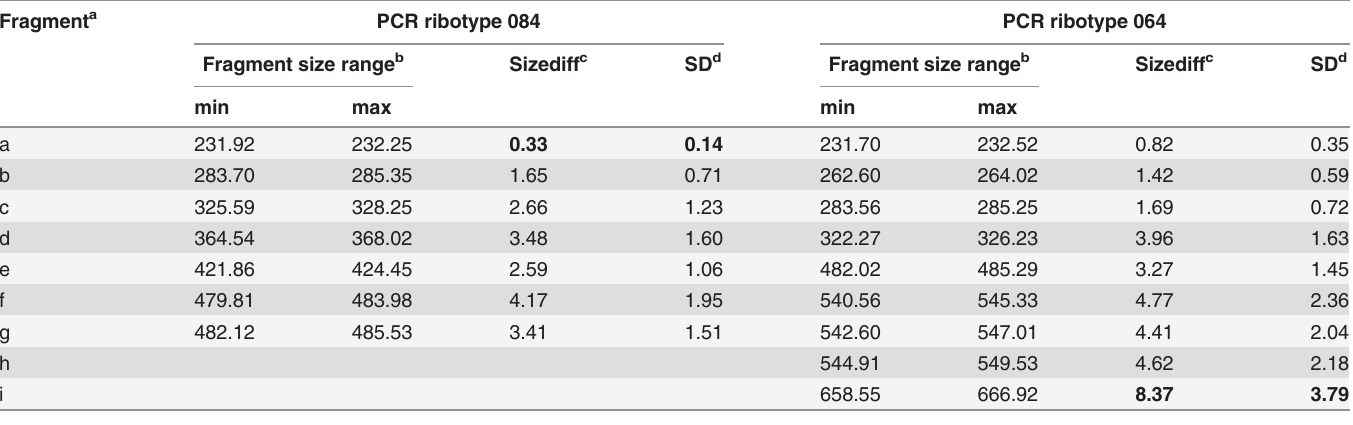
Table 3. PCR-ribotypes associated with minimum and maximum differences in DNA fragment sizes reported across participating centres. Fragment a